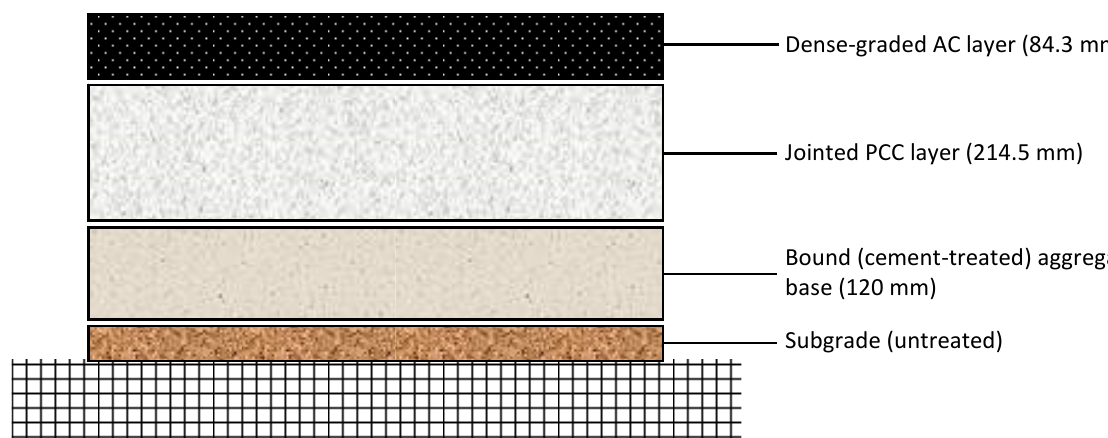
Figure 3. Pavement cross-section of LTPP test section 06-0603 (not in scale; data source: [33]).